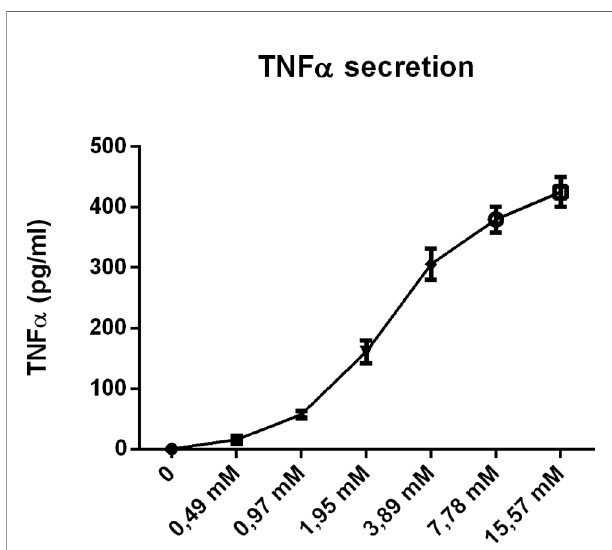
FIGURE 8 | Concentration dependency of the in fl ammatory effect of 2- hydroxypropyl- b -cyclodextrin. Dose response analysis of TNF a protein levels of Wt BMDM treated with 2-hydroxypropyl- b -cyclodextrin for